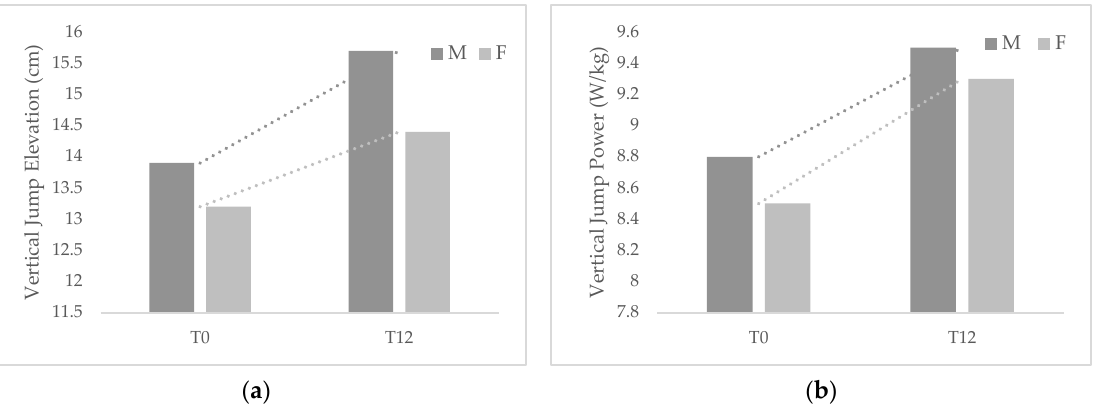
Figure 2. Changes occurred between baseline and 1-year follow-up in jump elevation ( a ) and jump power ( b ) among male (M) and female (F) participants.